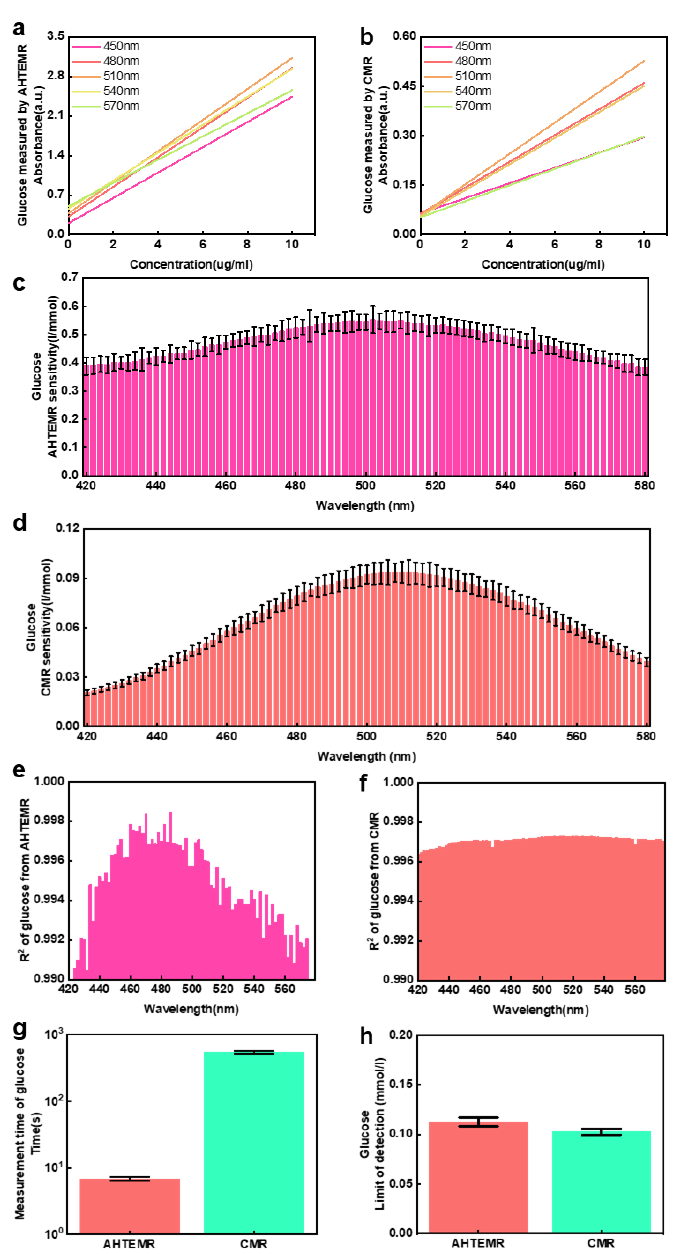
Figure 6. Glucose spectral measurement using the AHTEMR and CMR: ( a ) Absorbance spectrum linear fitting results of glucose at different wavelengths measured by the AHTEMR. ( b ) Absorbance spectrum linear fitting results of glucose at different wavelengths measured by the CMR. ( c ) Sensitivity distribution of linear fitting results between 420 and 580 nm measured by the AHTEMR. ( d ) Sensitivity distribution of linear fitting results between 520 and 580 nm measured by the CMR. ( e ) R 2 distribution of linear fitting results between 420 and 580 nm measured by the AHTEMR. ( f ) R 2 distribution of linear fitting results between 420 and 580 nm measured by the CMR. ( g ) AHTEMR and CMR measurements of the time spent on the spectral measurement of glucose solution per well. Between them, the AHTEMR costs about 6.87 s per well and the CMR costs about 536.6 s per well. ( h ) Detection limits of the AHTEMR platform and CMR for glucose measurement by a 3 δ calculation; the detection limit of the AHTEMR is 0.1126 mmol/L, while the detection limit of the CMR is 0.1027 mmol/L. All experiments are repeated in 3 well with error bars of mean ±